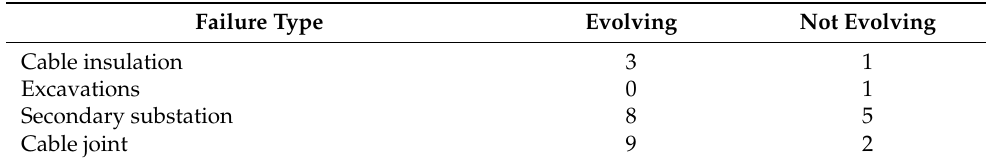
Table 2. Fault type of the observed failures.